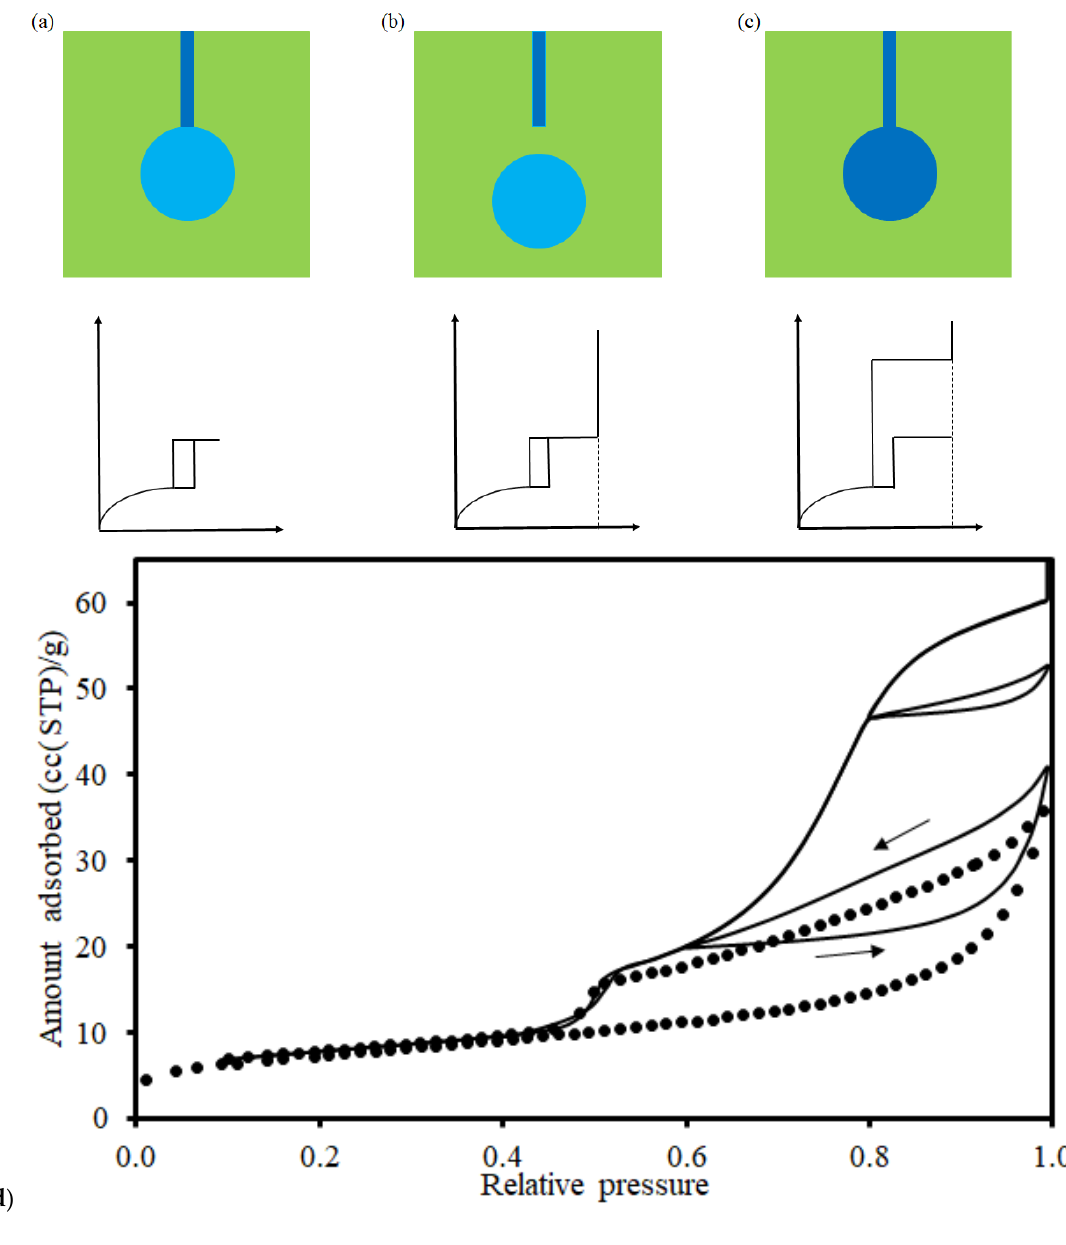
Figure 7. Schematic diagram depicting pore geometry and results anticipated from gas sorption experiments with ( a ) a nanopore (rectangle)-connected macropore (circle) in a conventional adsorption experiment, ( b ) a disconnected macropore in an overcondensation experiment, and ( c ) a nanopore-connected macropore in an overcondensation experiment. The dark (blue) shading indicates the presence of the condensate, whereas the light (blue) shading indicates an empty pore or vapour only. The dotted line in the idealised isotherm line plots indicates bulk condensation pressure. Reprinted from Rigby et al. [70] under Creative Commons CC-BY Licence. ( d ) Ascending adsorption scanning curves (starting at relative pressures of 0.6 and 0.8) and corresponding descending desorption curves (indicated by a descending arrow) for scanning loops starting on the overcondensation boundary desorption isotherm (solid line), and conventional isotherms for a thermochemically-treated Rempstone shale sample ( • ). It can be seen that the conventional isotherm misses a lot of porosity and leads to a misleading hystereis loop shape. Reprinted from Rigby et al. [71] under a Creative Commons CC-BY Licence.